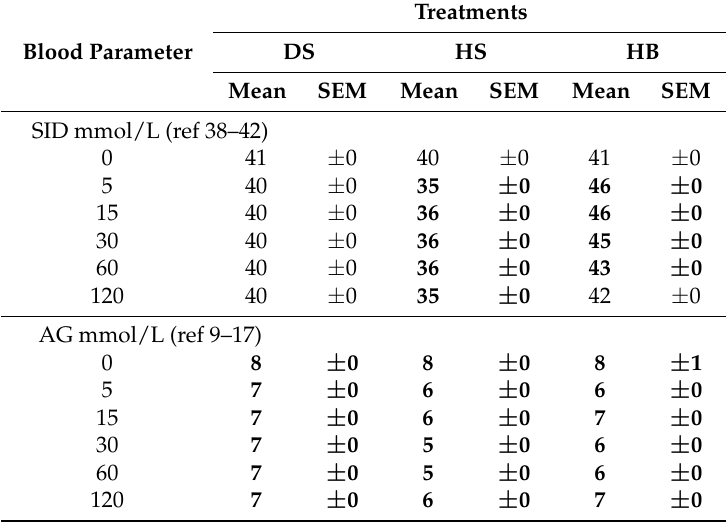
Table 6. Calculated Blood Results. Calculated changes in blood variables following intravenous infusion of DS, HB, and HS. DS (5% dextrose solution at 2 mL/kg bwt), HB (NaHCO 3 8.4% solution at 2 mmol/kg bwt), and HS (NaCl 7.5% solution at 4 mL/kg bwt). Numbers in bold for the following indicated values above or below the reference range for that blood